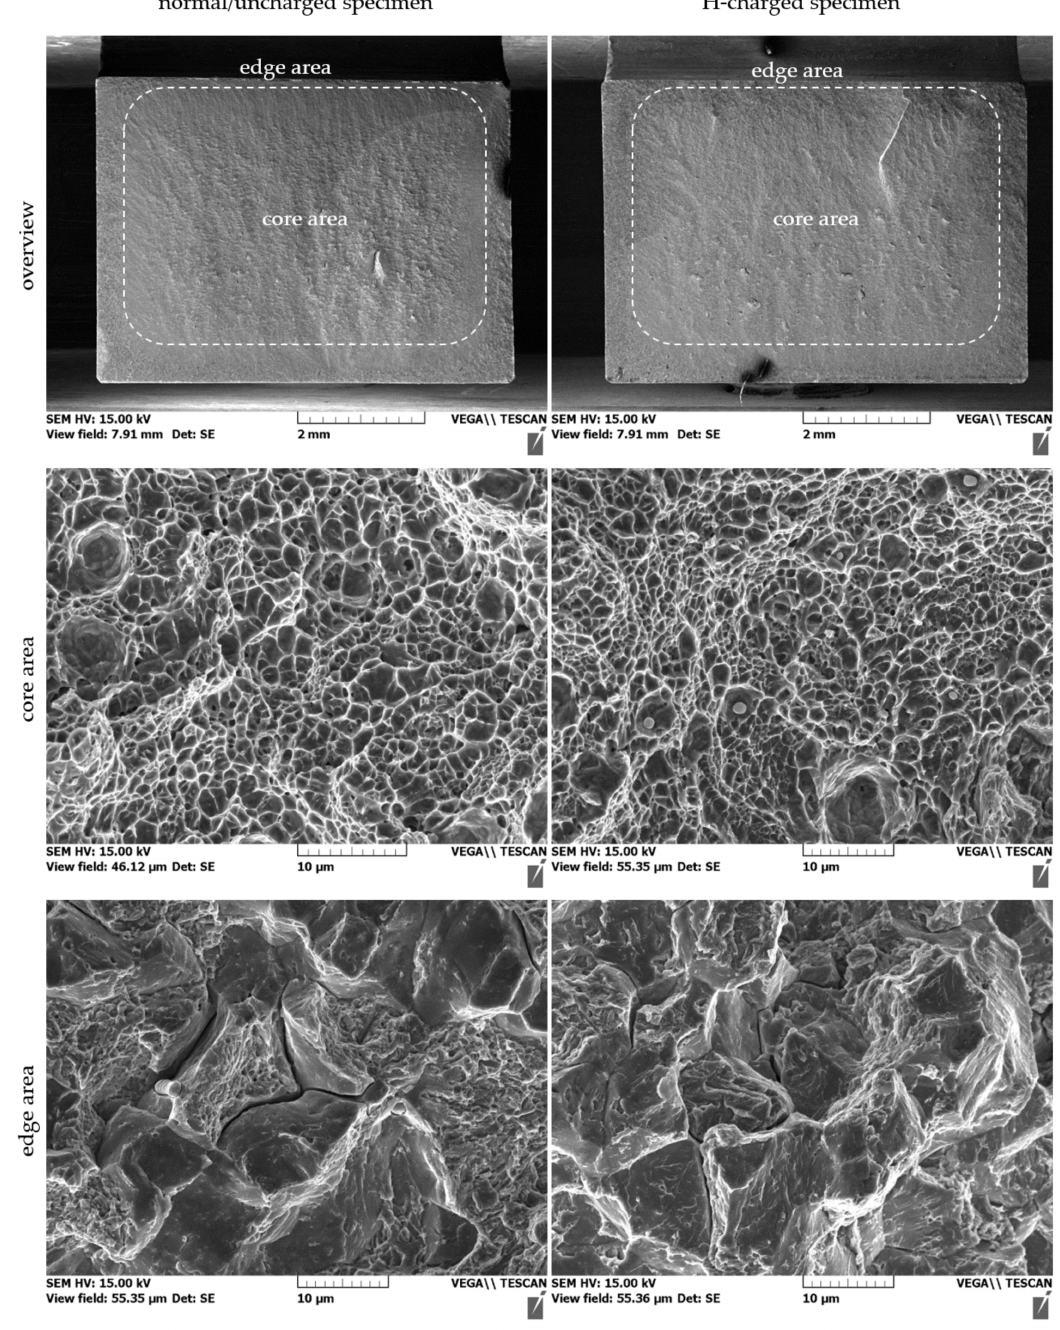
Figure 18. Fracture patterns of a normal and H-charged 4 point bending